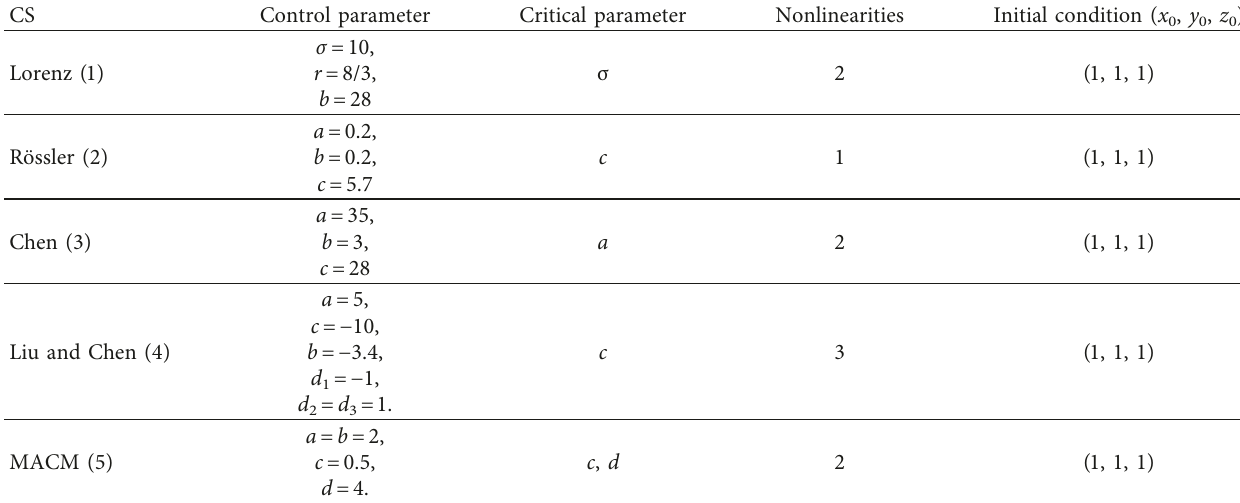
Table 1: Parameters, characteristics, and ICs of the five 3D CSs (1)–(5).